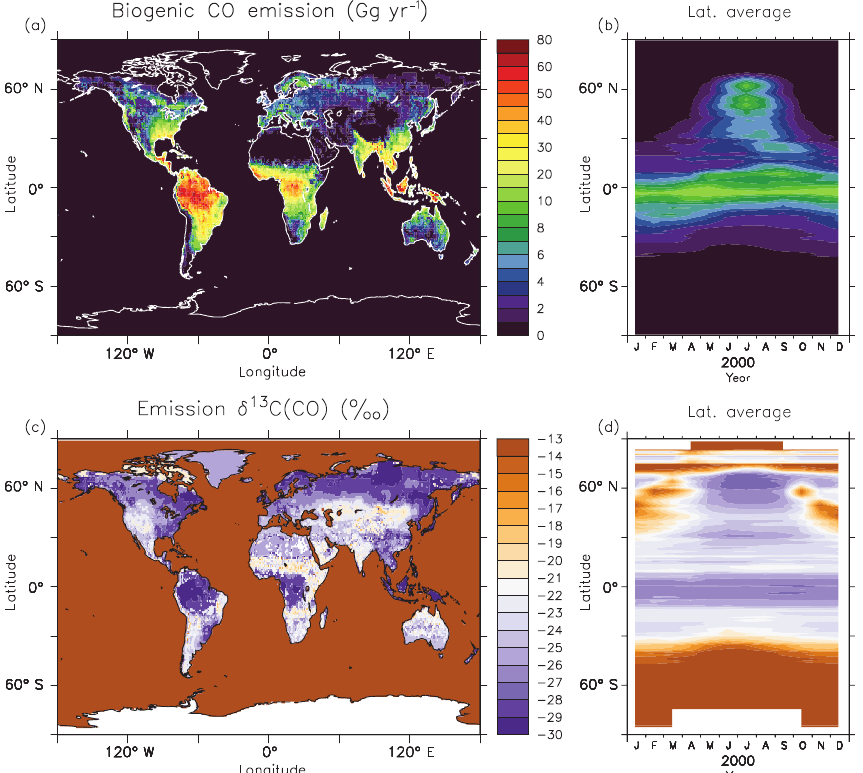
Figure 6. (a, c) CO emission from the biogenic sources (a) and corresponding isotopic signature (c) . (b, d) Corresponding time series of latitudinal averages for the year 2000 emission with identical colour